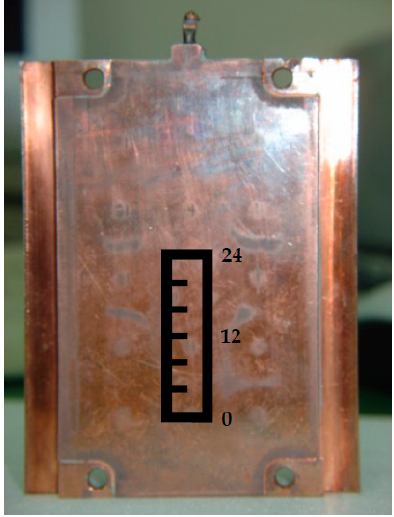
Figure 2. Photo of vapor chamber (VC).